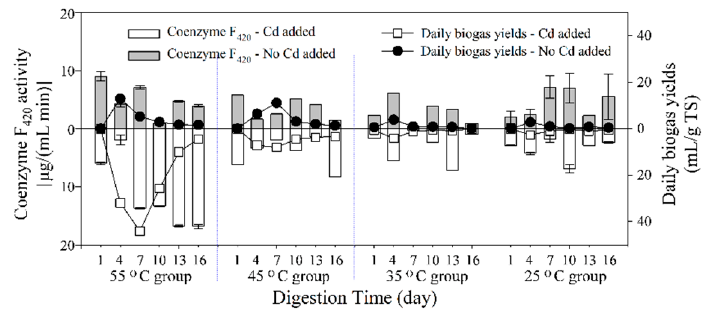
Figure 7. Coenzyme F 420 activity of the no Cd-added group and Cd-added group with digestion temperatures of 55 °C, 45 °C, 35 °C, and 25 °C.